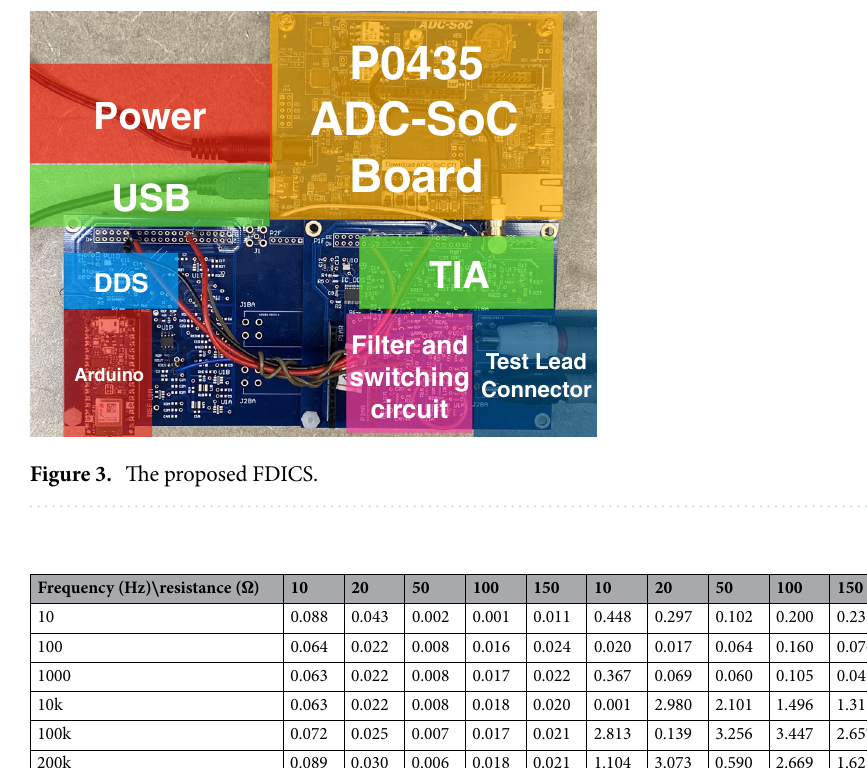
Table 2. The impedance magnitude and phase measurement error.